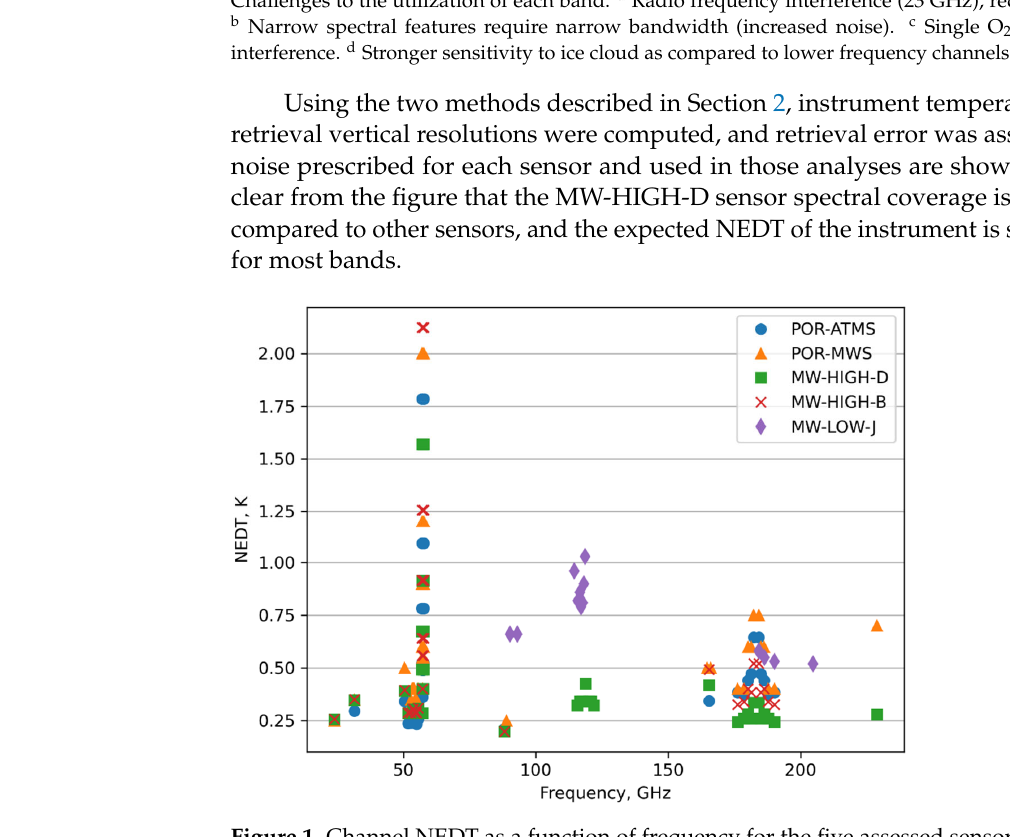
Figure 1. Channel NEDT as a function of frequency for the five assessed sensors.